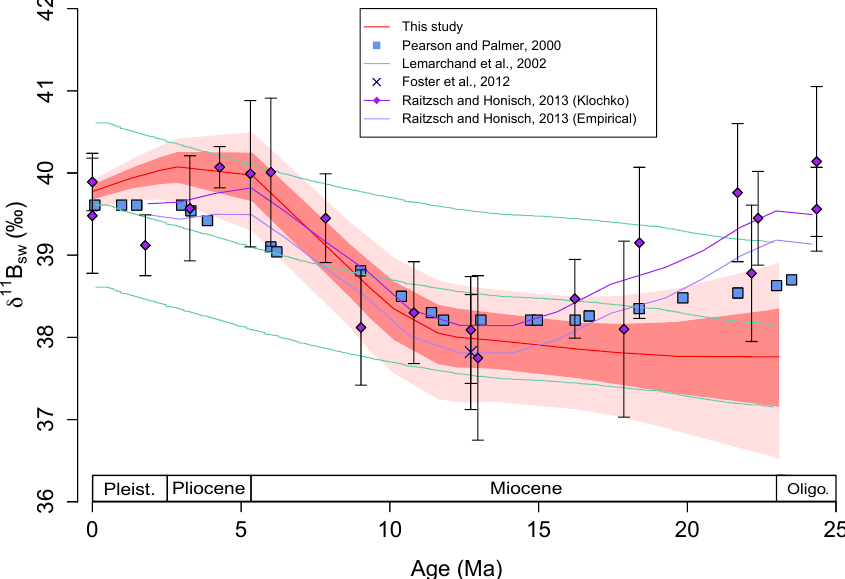
Figure 11. The δ 11 B sw curve calculated using the variable pH gradient derived from δ 13 C. The median (red line), 68% (dark red band) and 95% (light red band) confidence intervals are plotted. Plotted with a compilation of published δ 11 B sw records. Seawater composition reconstructed from foraminifera depth profiles (light blue squares and dark blue crosses) from Pearson and Palmer (2000) and Foster et al. (2012) respectively; numerical modelling (green line), with additional green lines showing ± 1‰ confidence interval (Lemarchand et al., 2000); and benthic δ 11 B (purple diamonds and dark purple line showing 5-point moving average is using the fractionation factor of Klochko et al., 2006, light purple line showing 5-point moving average using an empirical calibration) from Raitzsch and Hönisch (2013). All the published δ 11 B sw curves are adjusted so that at t = 0 and the isotopic composition is equal to the modern